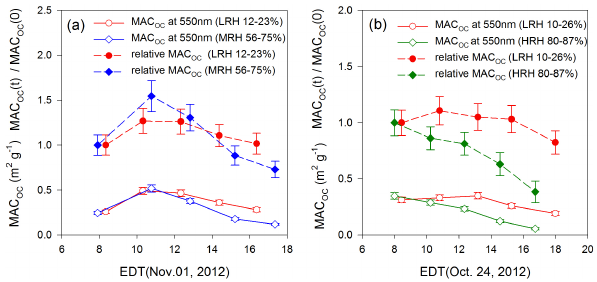
Fig. 3. Comparison of light absorption of wood OA photochem- ically oxidized at different conditions: (a) low NO x vs. medium NO x , and (b) low NO x vs. high NO x . The open symbols are for MAC OC at 550nm. The filled symbols are for the relative MAC OC , which is expressed as the total MAC OC divided by initial total MAC OC . The uncertainties associated with OC mass absorption cross section in Eqs. (1)–(3) are estimated using propagation of er- rors from OC/EC analyzer, UV–visible spectrometer, and the cor- rection factor f (Eq. 5). Uncertainty of OC/EC analyzer was deter- mined by dividing 0.5µgm − 3 (the absolute error) by the measured OC value. Uncertainty of UV–visible spectrometer was determined by dividing 0.002 (the absolute error) by the measured absorbance. The standard error of f is 8%, which is estimated from the linear regression of calibration data (Zhong and Jang,